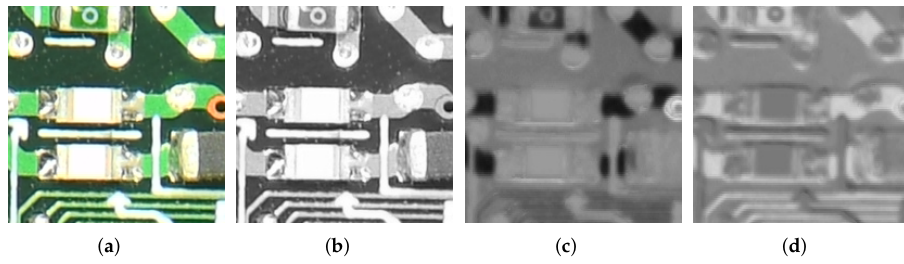
Figure 6. ( a ) The original PCB image; ( b ) L channel of the image; ( c ) A channel of the image; ( d ) B channel of the